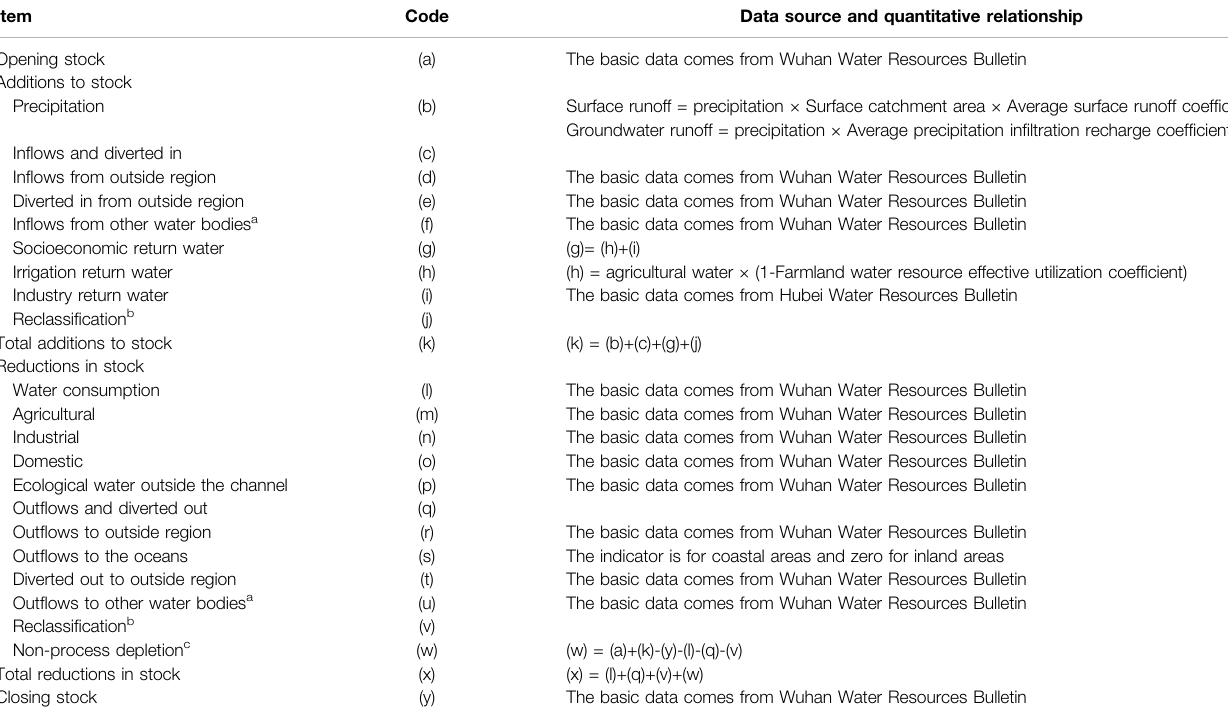
TABLE 1 | Regional water stock and change statement (in 100 million m 3